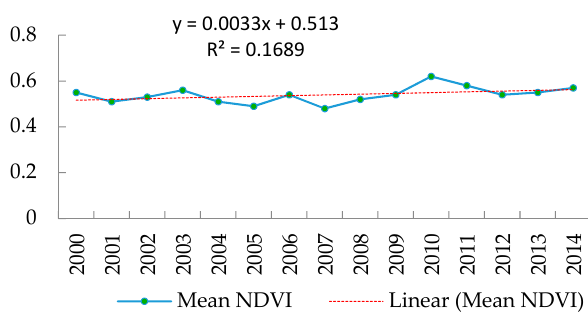
Figure 3. Growing Season mean NDVI changes in the Virunga Volcanoes massif from 2000 to 2014.